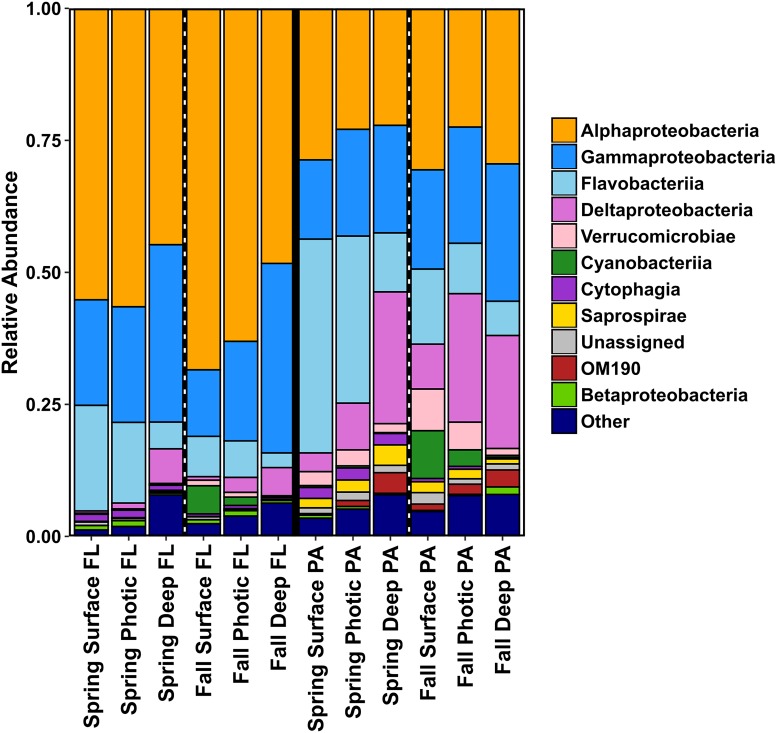
Bar charts showing relative abundances of the bacterial community taxa of the different size fractions (PA and FL), split into season and depth categories for 2014. Results are summed and averaged for all samples within each season and depth category.